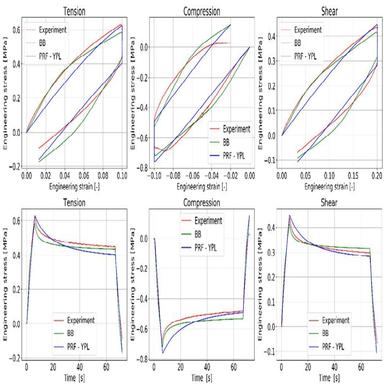
omparison of experimental and predicted curves for strain rate 1s-1.